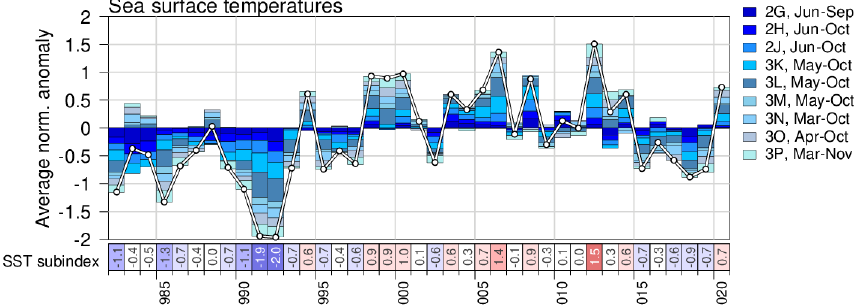
Figure 6. Sea surface temperature (SST) composite index in NAFO sub-areas 2 and 3 since 1982. This index is built by performing a spatially weighted average of the seasonal SST normalized anomalies for each NAFO division (divisions and months used are provided on the right-hand side of the figure). The numerical values of the normalized anomalies are provided in a colour-coded (red, warm; blue, cold) scorecard at the bottom. This time series is one component of the NL climate